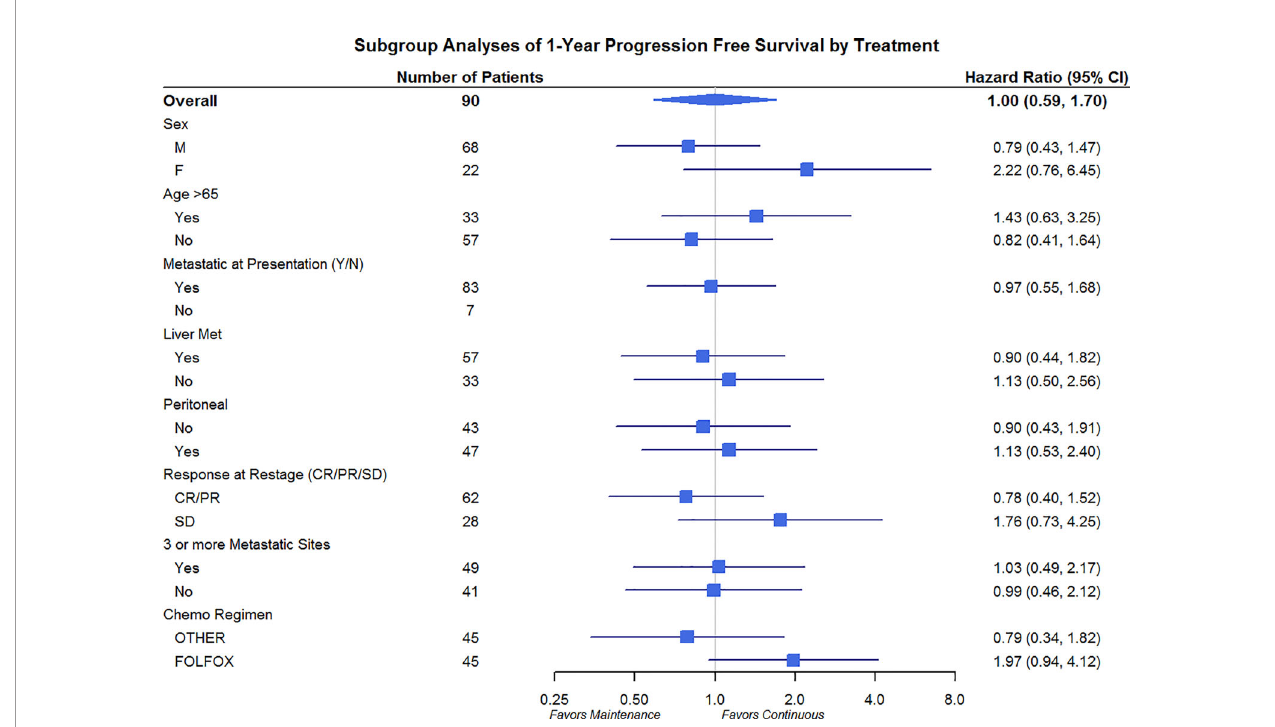
FIGURE 6 | Progression-Free Survival Subgroup Analysis at 1 year: Gender, Age, Metastatic Site, and Chemo